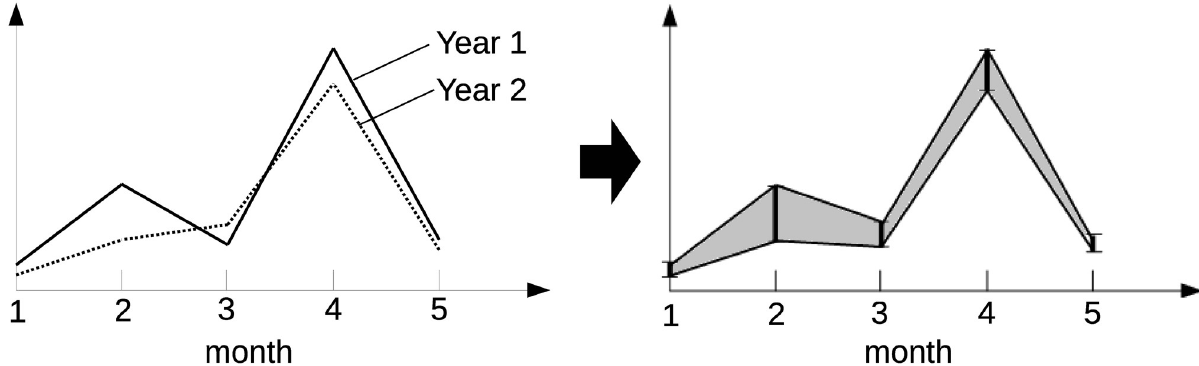
Fig 1. An image of transforming seasonal factors to an interval-valued seasonal